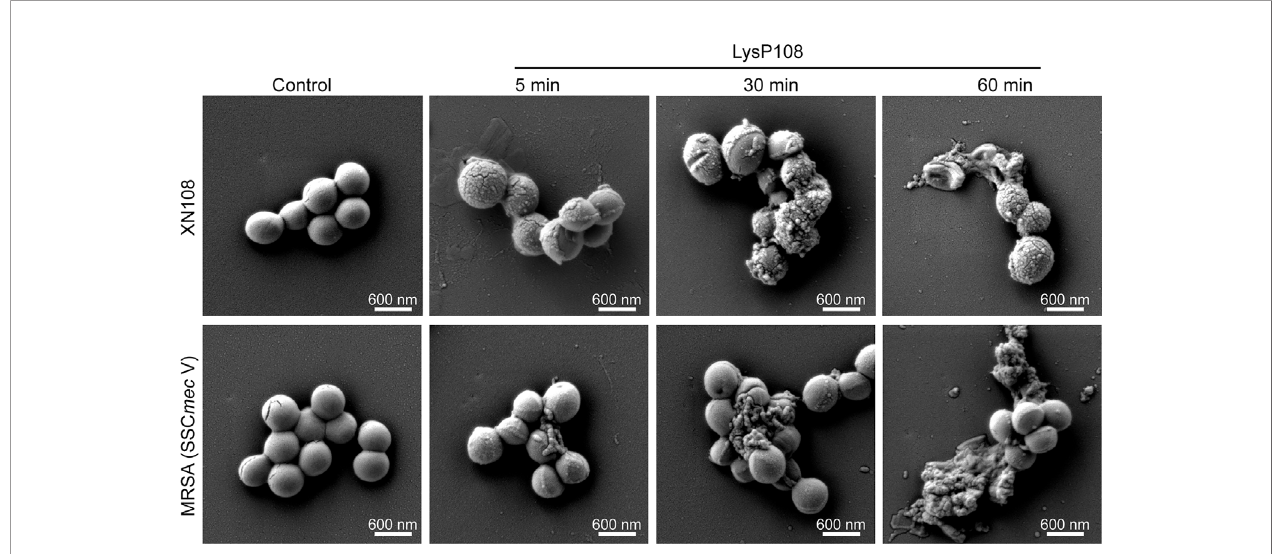
FIGURE 5 | SEM micrographs of MRSA strains (XN108 and SCC mec V) after incubation with LysP108 and PBS for different